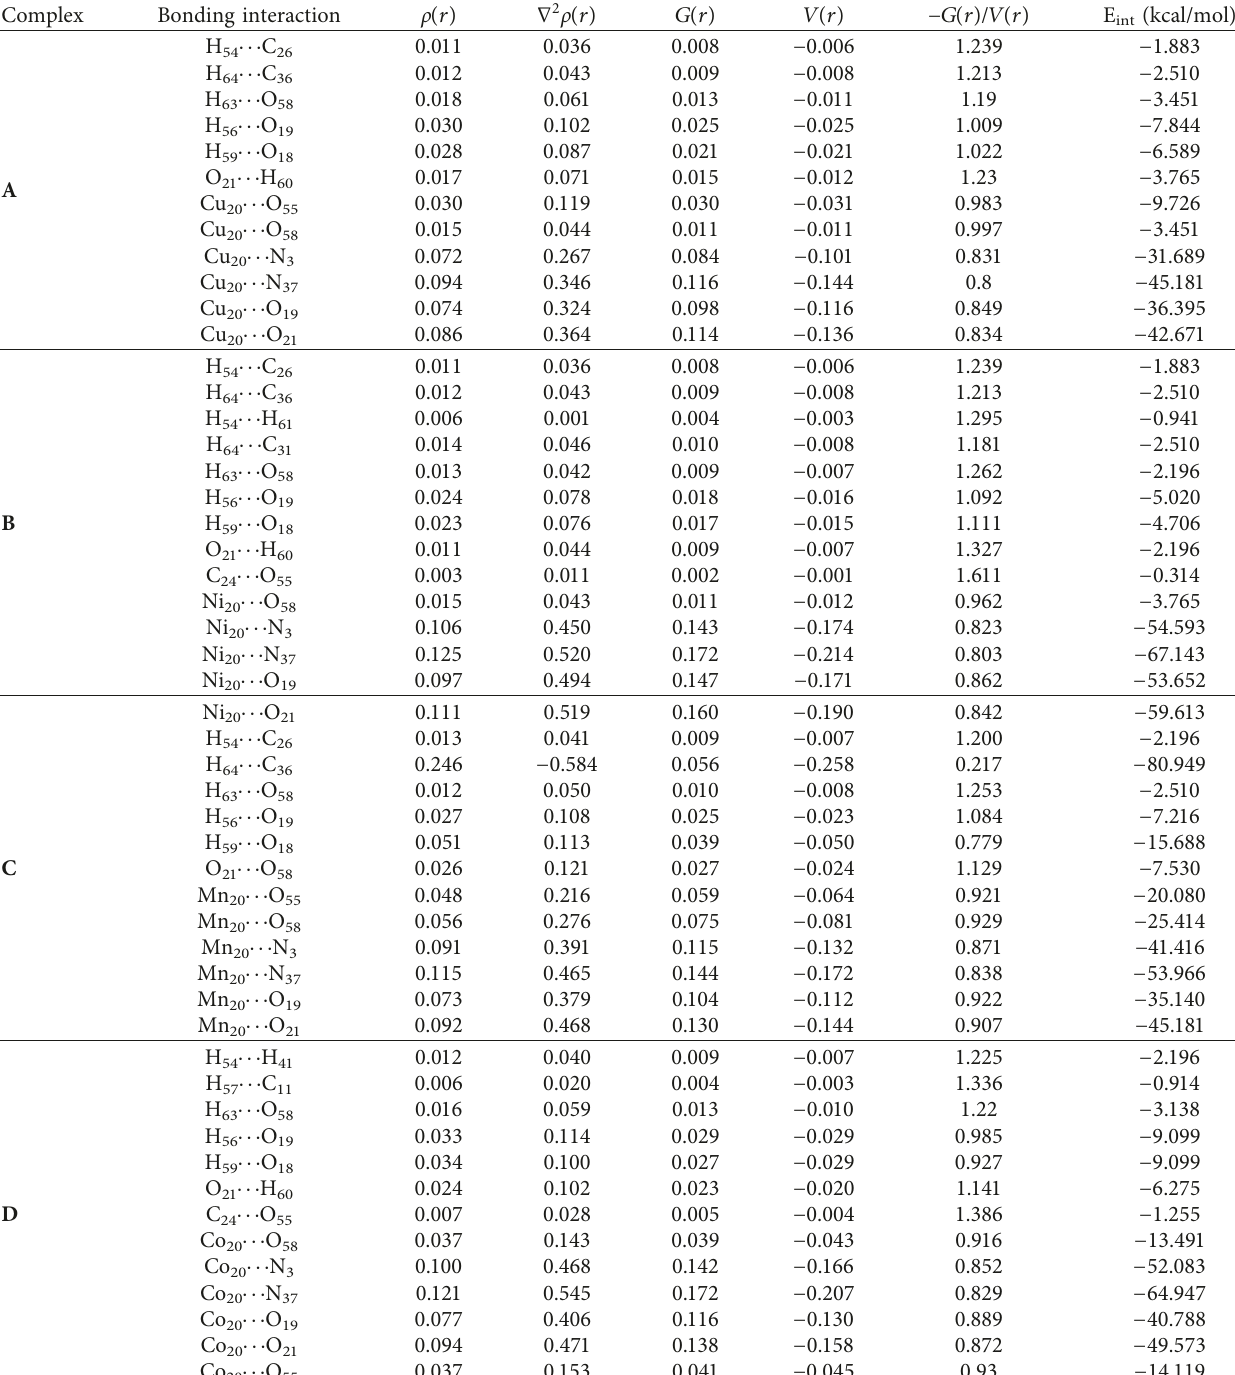
Table 3: Bonding interactions and values of the electron density [ ρ ( r )] and its Laplacian [ ∇ 2 ρ ( r )], kinetic energy density [ G ( r )], potential energy density [ V ( r )], and interatomic interaction energy (E int ) for the noncovalent and covalent bonding interactions in the complexes studied. Complex Bonding interaction